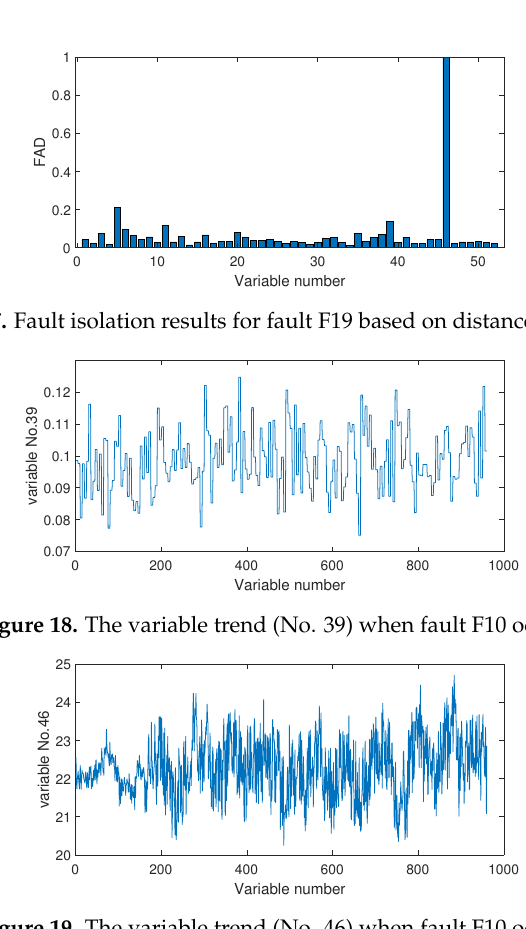
Figure 19. The variable trend (No. 46) when fault F10